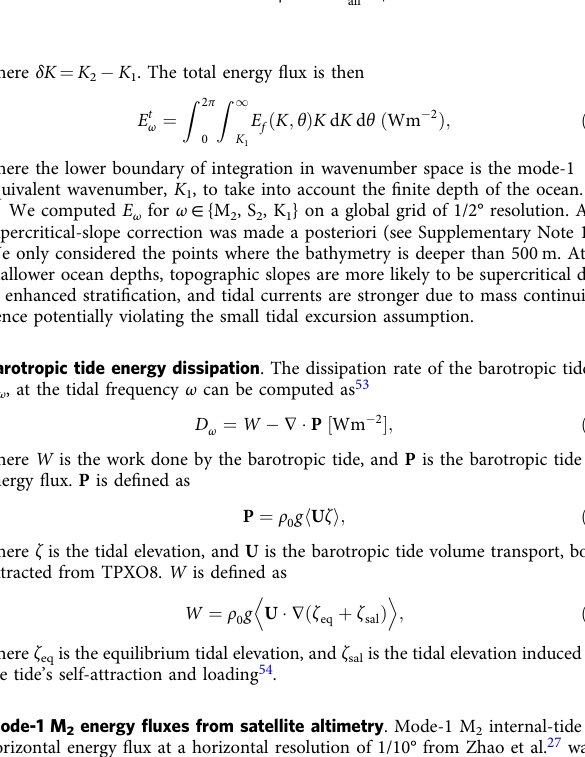
, and the ratio our estimate all